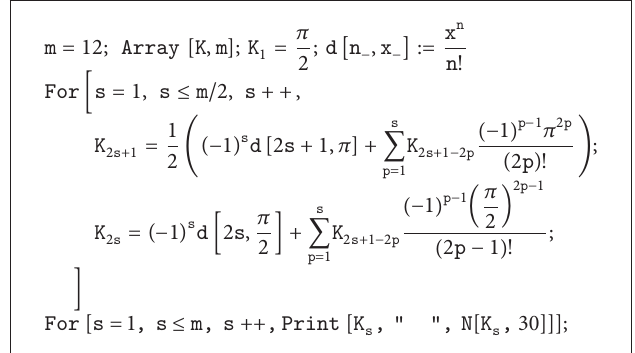
Algorithm 1: Mathematica code for exact symbolic and approximate computation with optional 30 digits accuracy of the Favard constants by recursive representations (7a) and